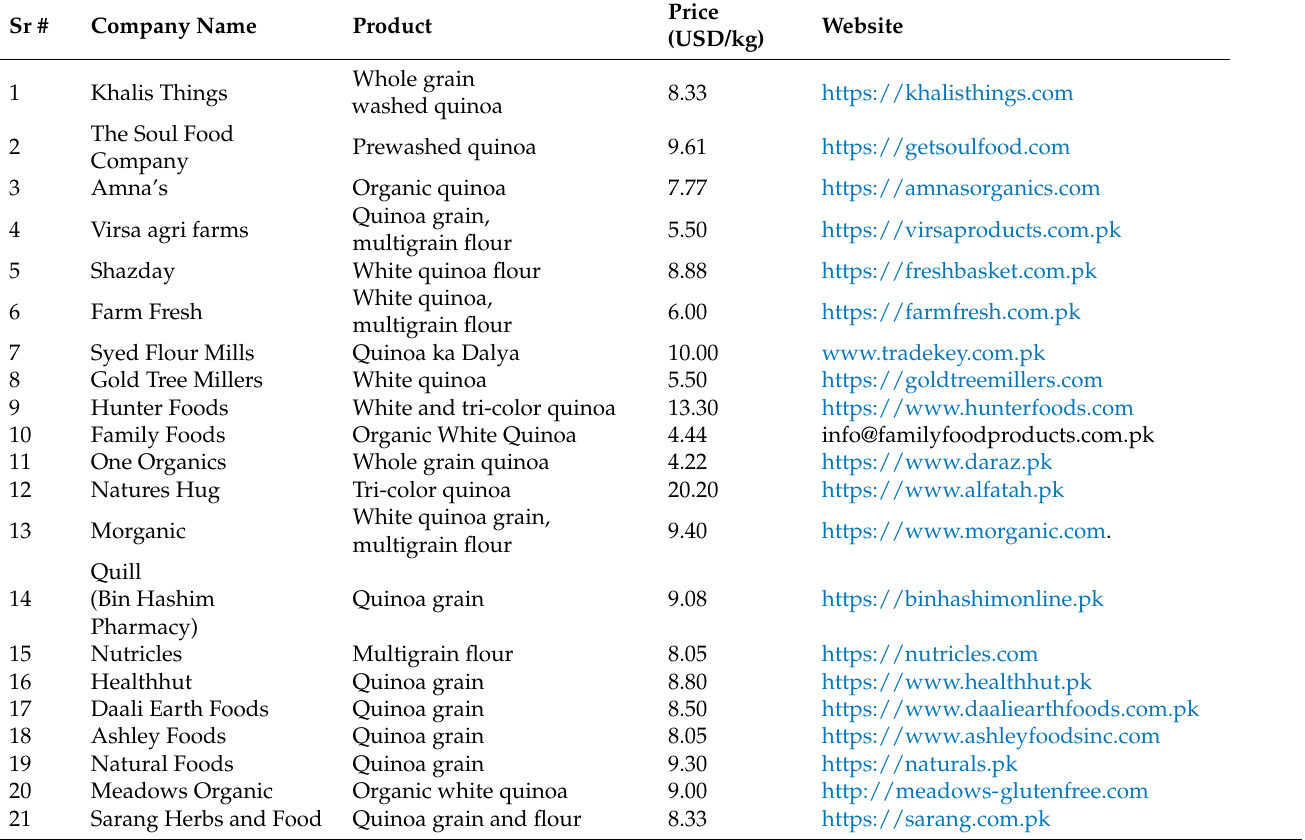
Table 4. Companies marketing quinoa products in Pakistan. (Website accessed date is 8 June